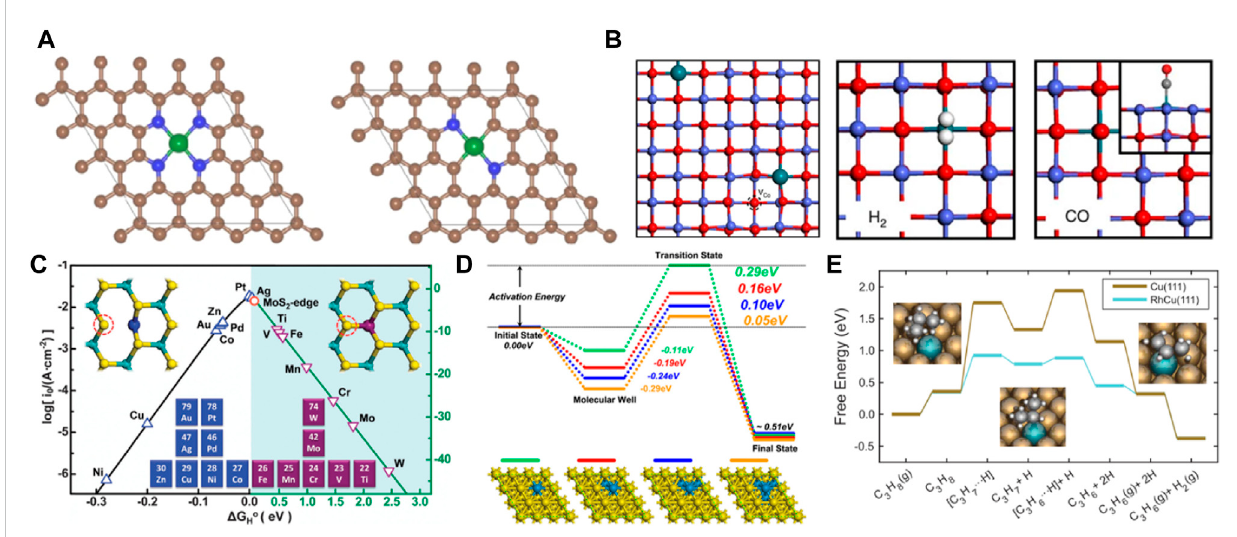
FIGURE 2 (A) Ni – SACmodeldiagramcontainingNi – N 4 andNi – N 2 C 2 moietiesasactivesitesforCO 2 RR( fi gureusedwithpermissionfromLuoetal.,2020). (B) ThemodelofRh 1 /CoO andtheadsorption con fi gurationsofH 2 andCO onRh 1 /CoO ( fi gureused withpermissionfromZeng etal., 2016) (C) The volcano curve relation between currents [log( i 0 )] and △ G H 。 . The inserted diagram points to different doped MoS 2 con fi gurations ( fi gure used with permission from Luo et al., 2013). (D) Energy pro fi les of H 2 dissociation and structure diagram of Pd-doped Cu(111) surfaces ( fi gure used with permission from Luo et al., 2013). (E) Free-energy diagram of RhCu (111) SAA and Cu(111) for the formation of propylene. (Figure used with permission from Sykes et al.,